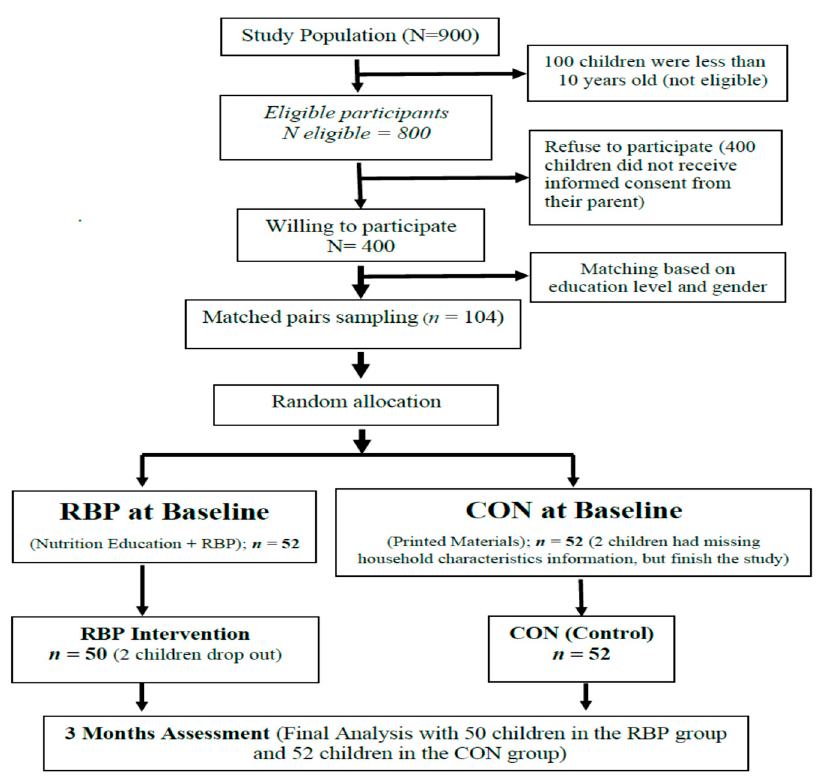
Figure 2. The CONSORT diagram of the study.